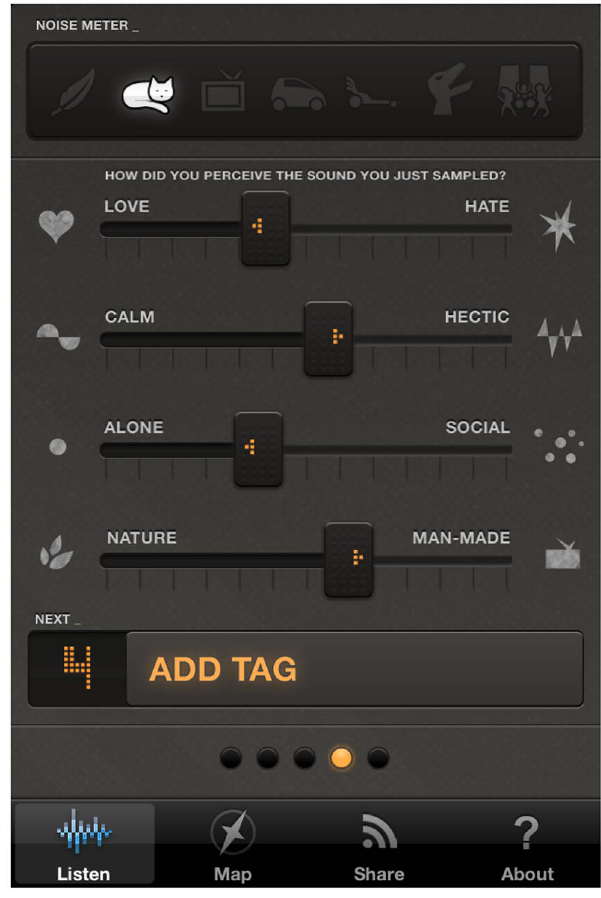
Figure 1. Noise sample screen for WideNoise Plus mobile application.